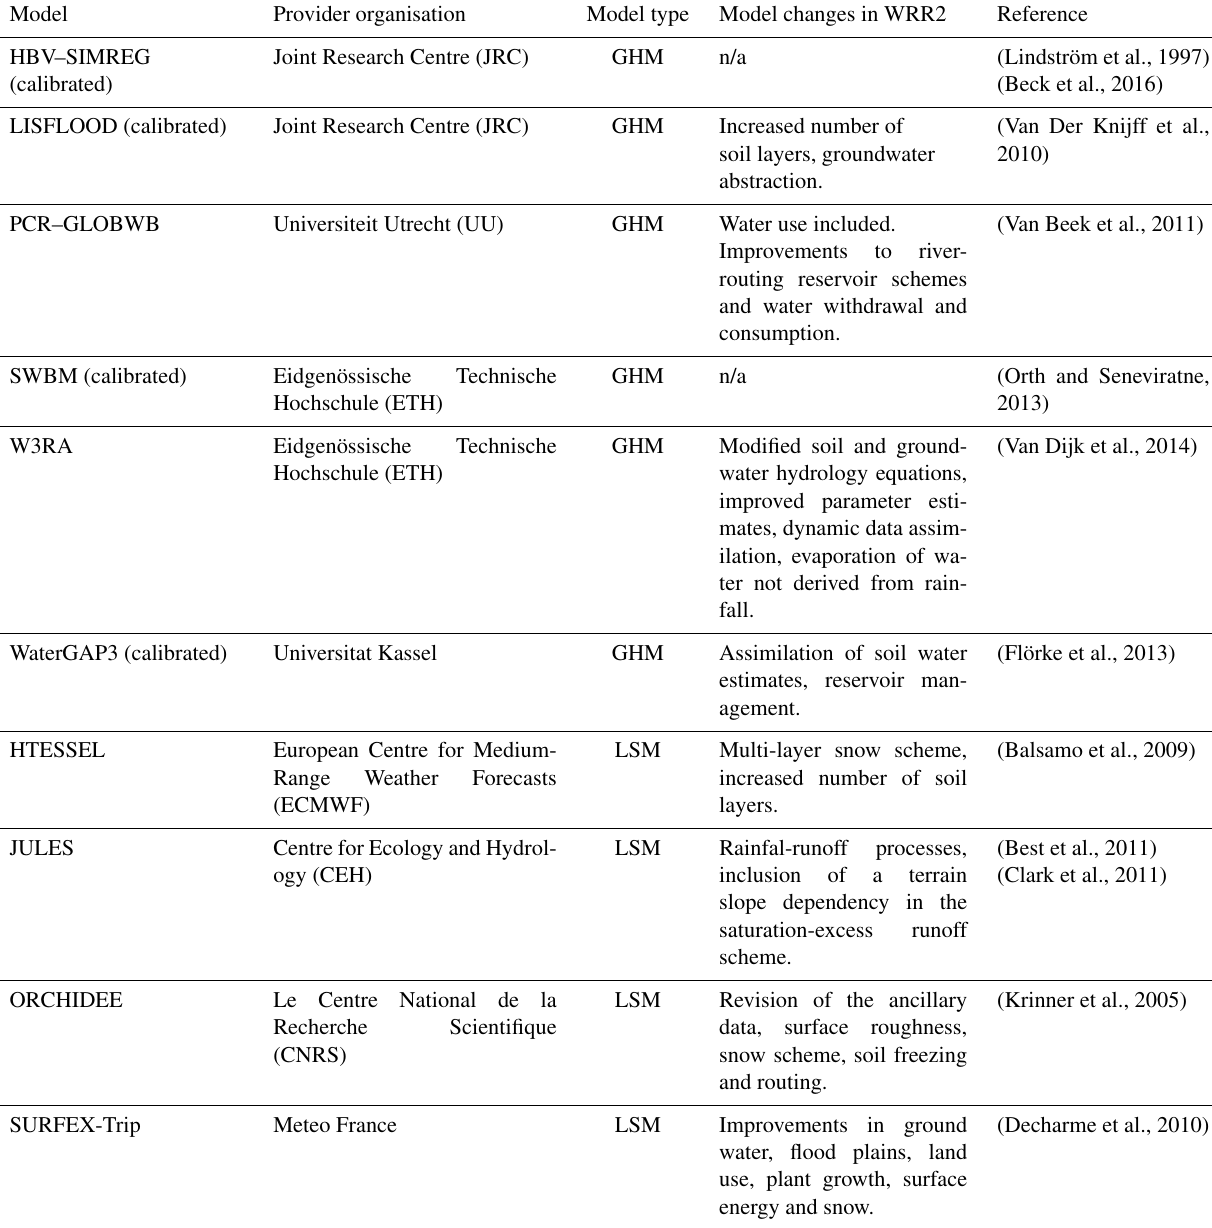
Table 1. Overview of models and main changes from WRR1 to WRR2. Note that not all models included in WRR1 were run for WRR2, in which case no changes are noted in the table. Models that have been calibrated against publicly available streamflow data are